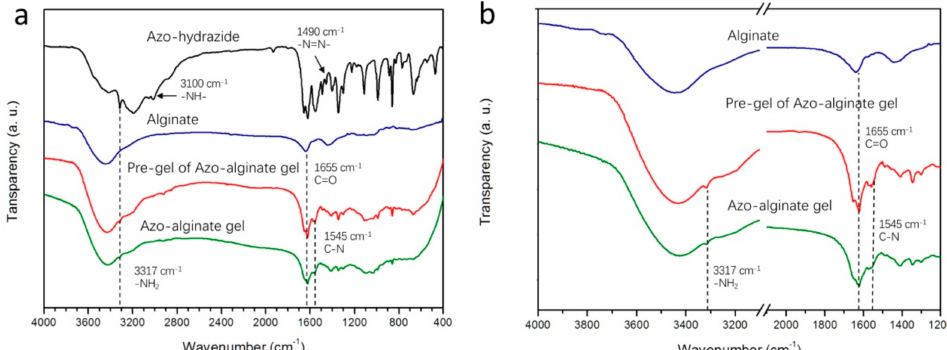
Figure 2. ( a ) The FTIR spectra of the Azo-hydrazide, alginate, pre-gel and Azo-alginate gel. ( b ) The FTIR spectra of the alginate pre-gel and Azo-alginate gel, showing the spectra at wavenumber ranges of 4000–3000 cm − 1 and 2500–1200 cm − 1